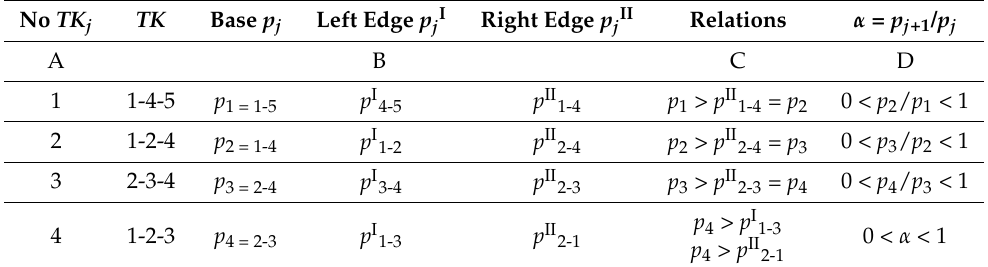
Figure 7. Operation of contractive self-mapping of a polyline into triangles TK . Table 1. Results proving the Lipschitz condition for constant α < 1 in the contractive mapping of a